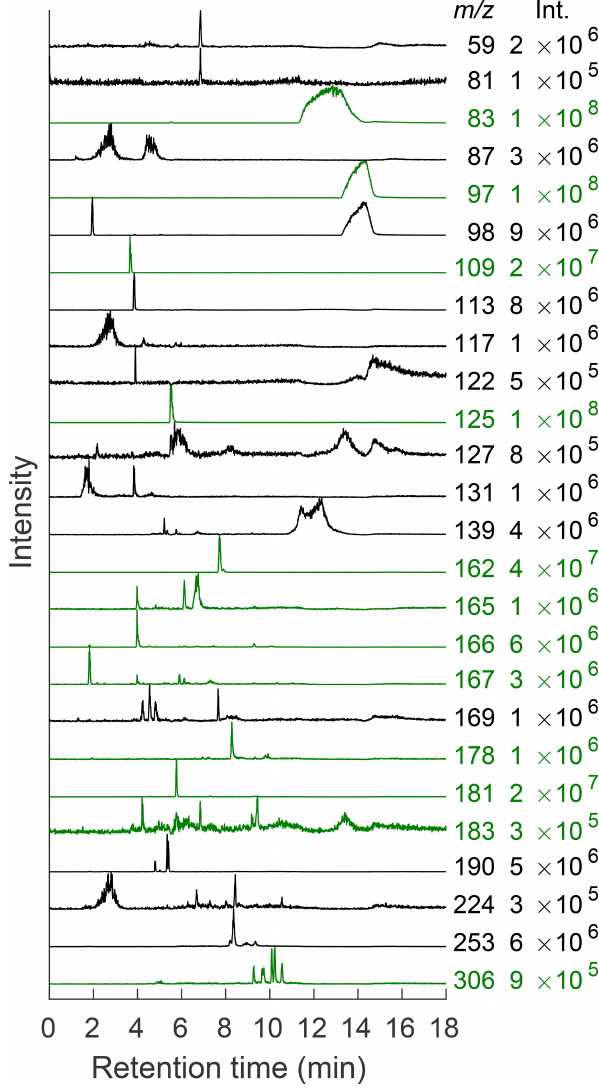
Figure 5. EICs of selected m/z values seen under the conditions described above. The intensity of the largest peak is given to the right of each trace. All chromatograms have been normalized to their maximum value for ease of viewing due to the very intense signals given by imidazole derivatives. Traces shown in green cor- respond to masses that have been identified in previous work. Those in black have not yet been published for this system (Lin et al., 2015; Hawkins et al.,